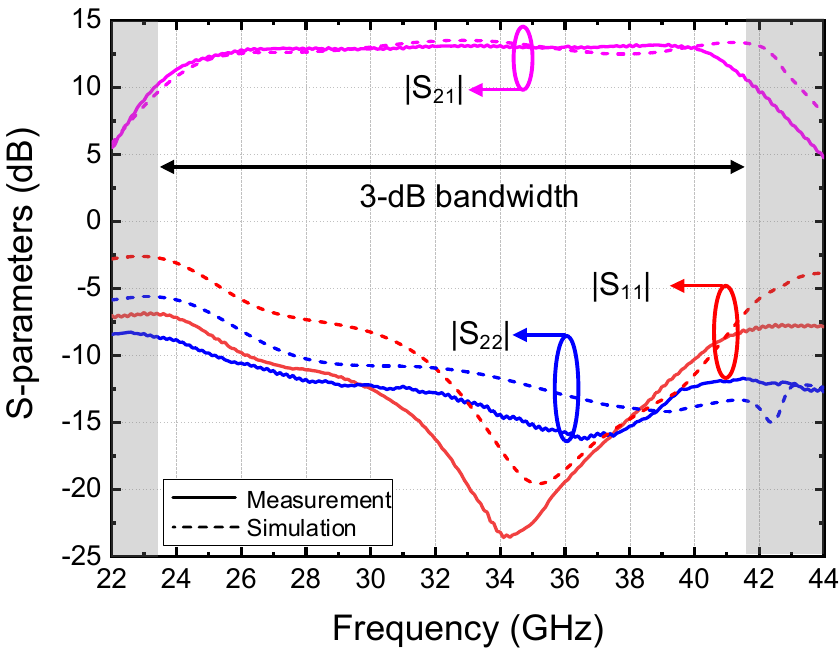
Figure 9. Measured S-parameters of the full Ka-band amplifier.